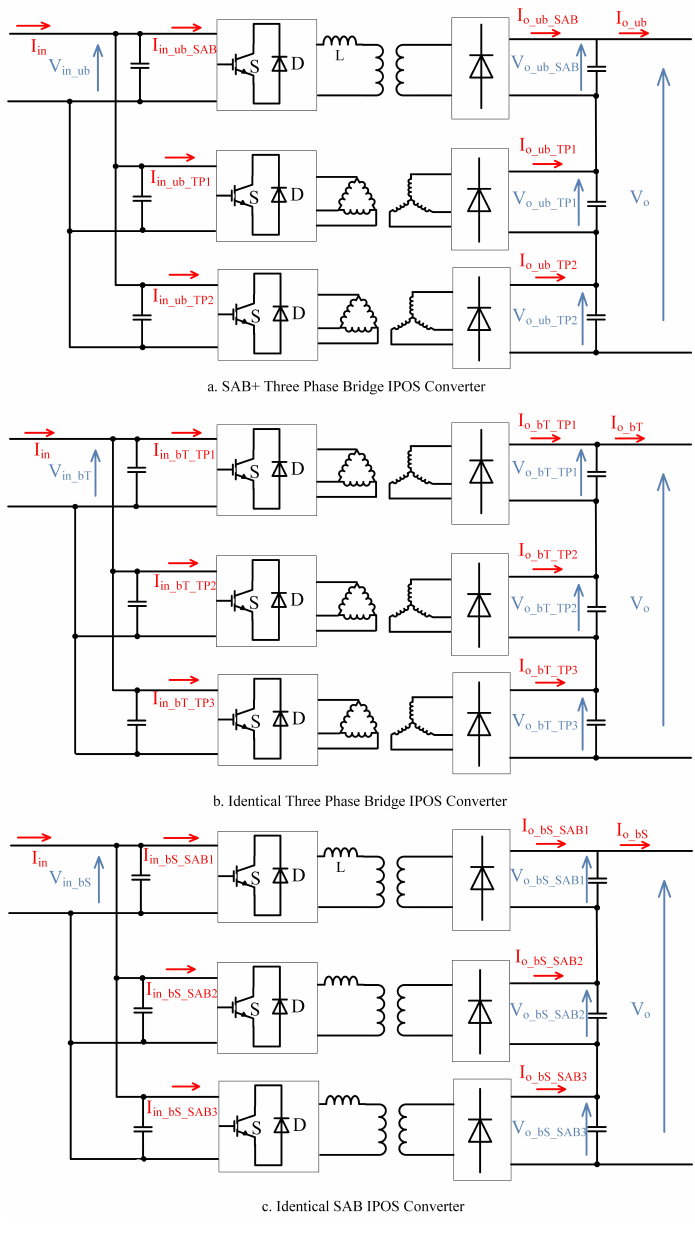
Figure 4. Three different unidirectional IPOS converter structures